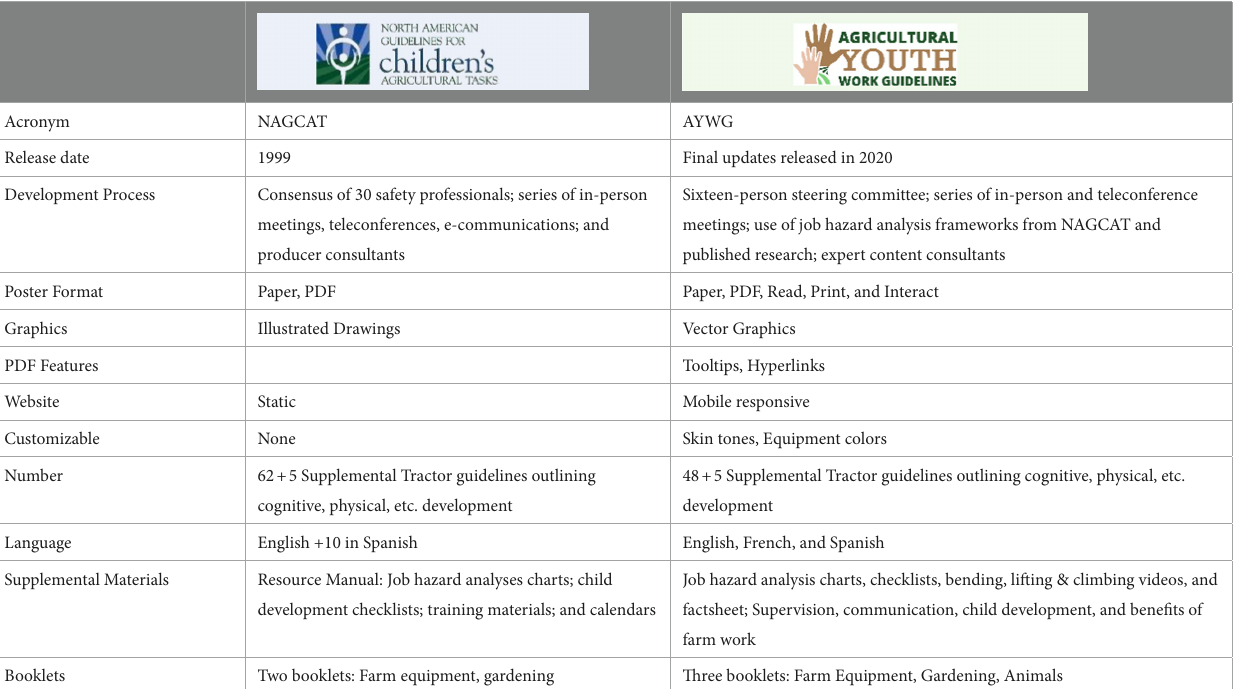
TABLE 1 Comparison of work